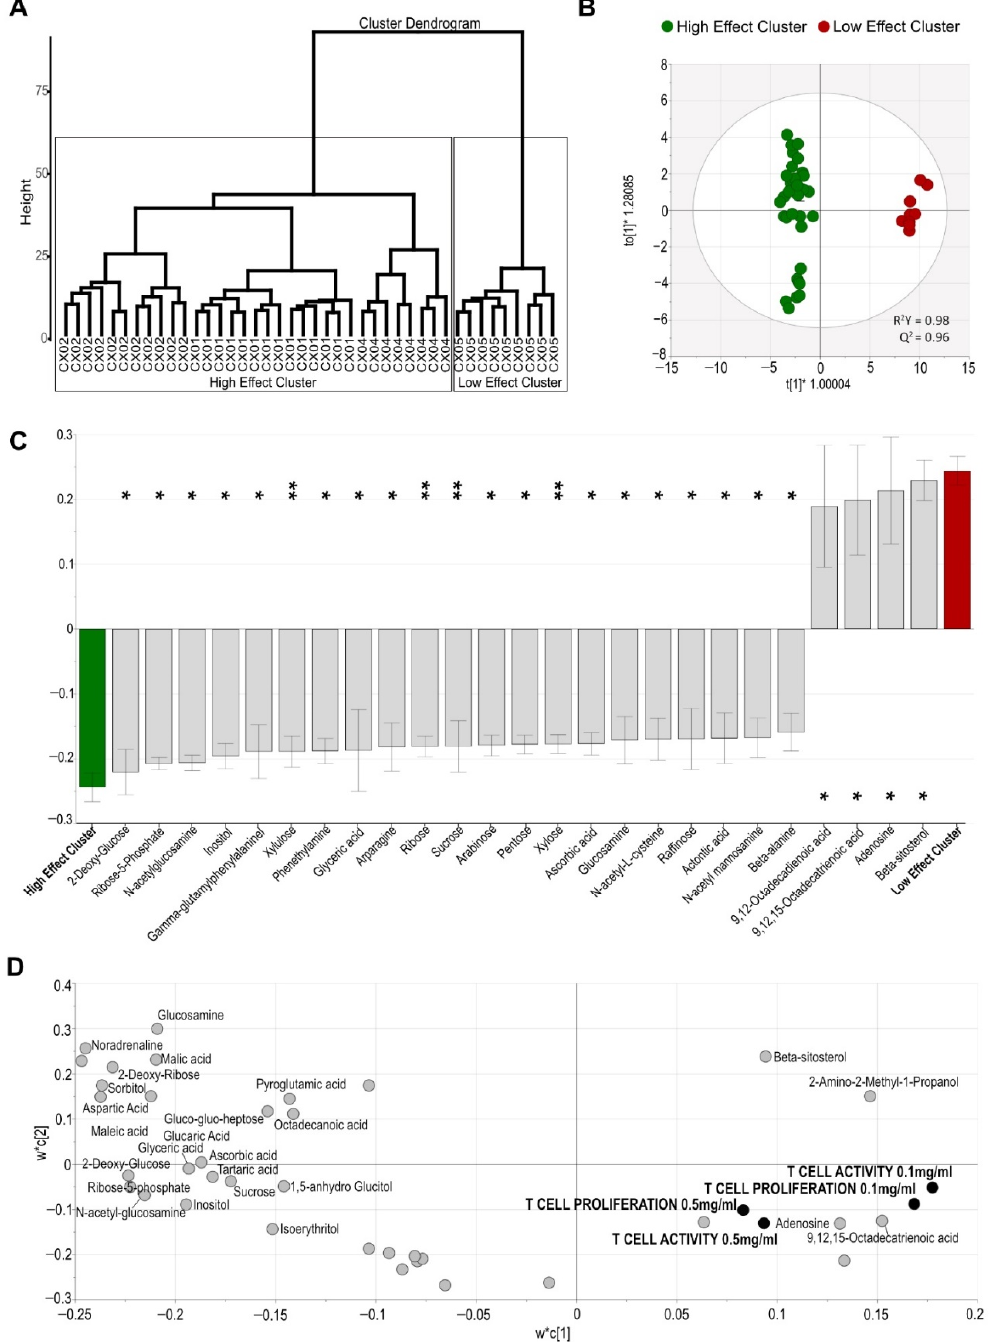
Figure 4. Aloe extract clusters based on their distinct metabolite composition associate to their immune cell activity. ( A ) Hierarchical cluster dendrogram for Aloe extracts based on their metabolite profile and identification of a High and a Low Effect Cluster. ( B ) Multivariate orthogonal partial least squares ‐ discriminant analysis (OPLS ‐ DA) score scatter plot showing discrimination between the High Effect Cluster compared to the Low Effect Cluster, based on the 25 most discriminatory metabolites (VIP > 1.2). ( C ) Metabolites differing between the Aloe extract clusters associated with High Effect and Low Effect. Error bars indicate 95% confidence intervals. ( D ) PLS loading scatter plot depicting the relation between the relative abundance of metabolites (light gray dots) and their effect on immune cell activity (black dots) in the presence of 0.1 and 0.5 mg/mL Aloe (VIP > 1.0). Asterisks represent significant q values: * <0.05; ** <0.01; VIP, variable influence on